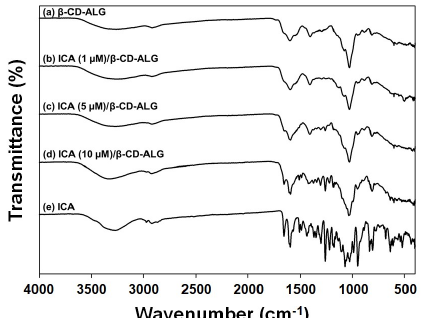
Figure 2. FT-IR spectra of ( a ) β -CD-ALG, ( b ) ICA (1 µ M) / β -CD-ALG, ( c ) ICA (5 µ M) / β -CD-ALG, ( d ) ICA (10 µ M) / β -CD-ALG, and ( e ) ICA.